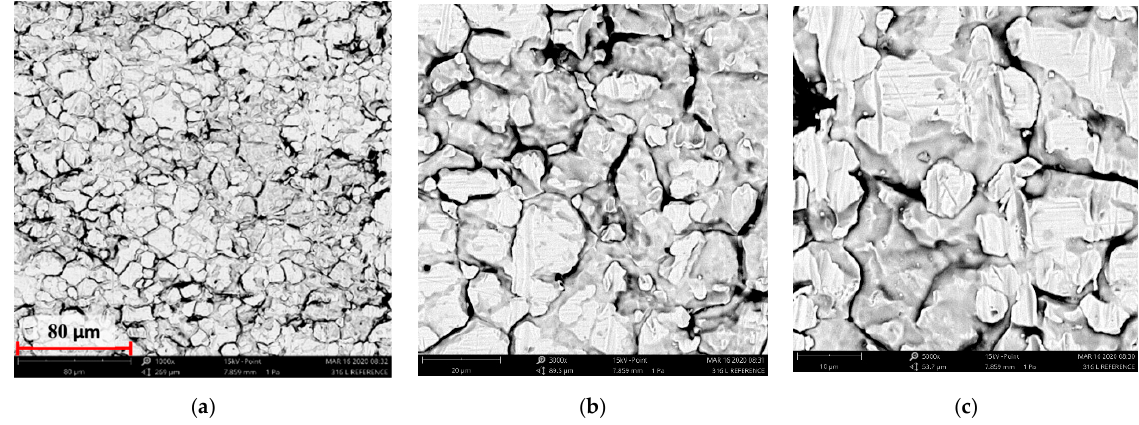
Figure 4. SEM image of the reference sample—316L: ( a ) ×1000, ( b ) ×3000 ( c ) ×5000.